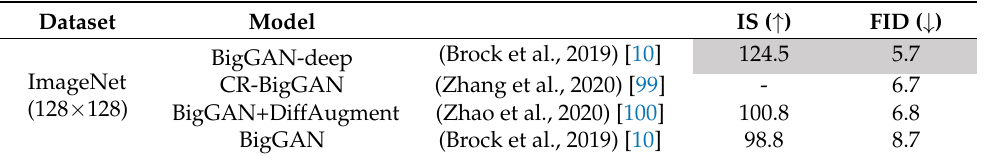
Table 10. The IS and FID of different models trained on ImageNet dataset. The higher the IS value, the better the performance. The lower the FID value, the better the performance.